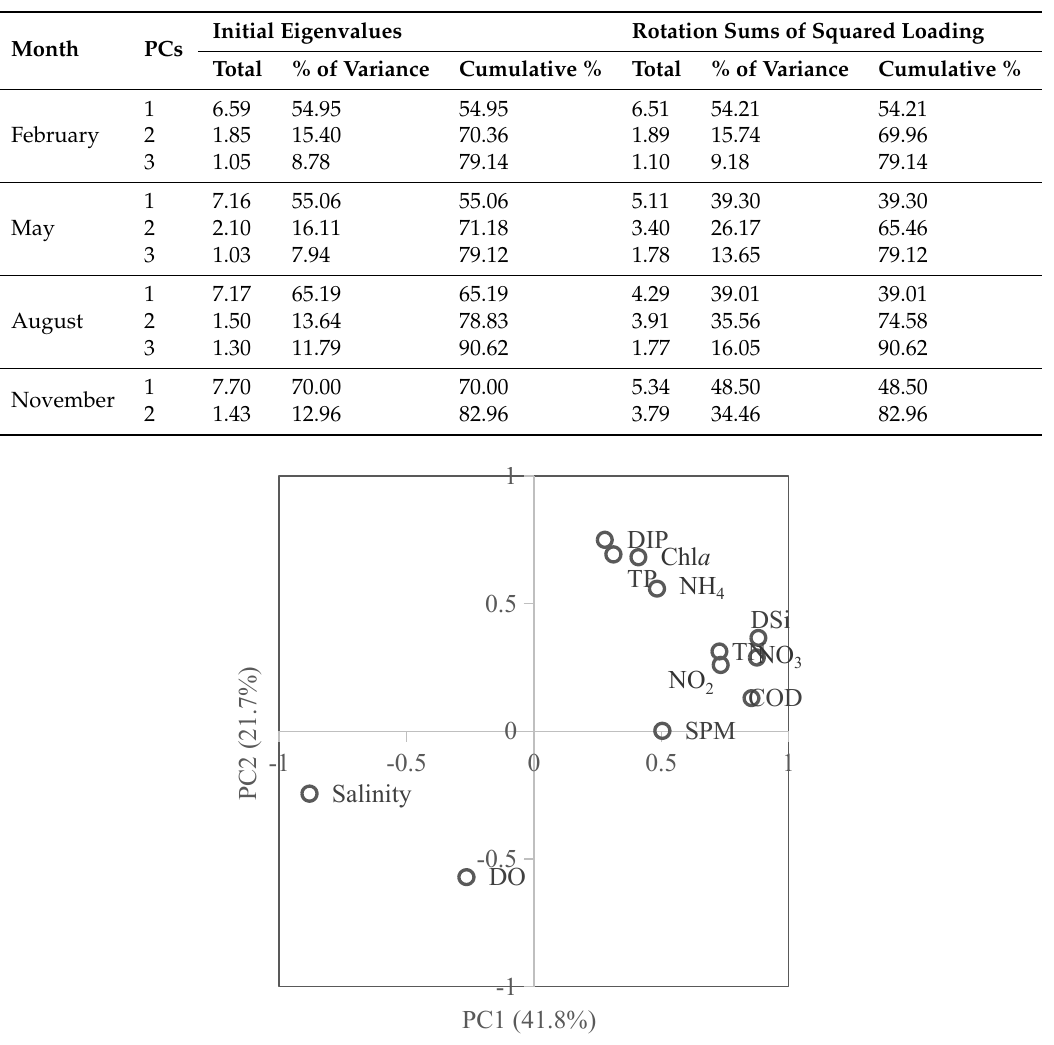
Table 3. PCA-generated component loading between phytoplankton chlorophyll and multiple environmental factors in the estuary.